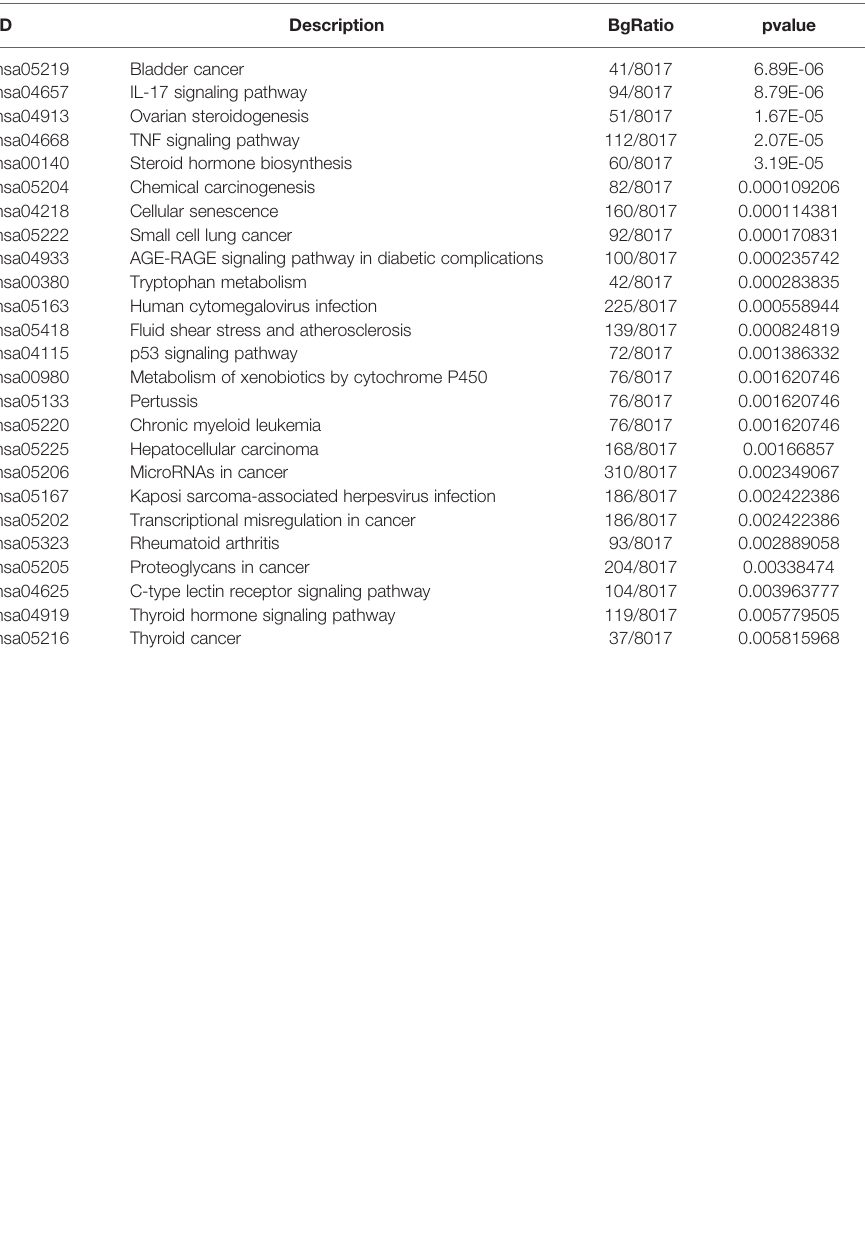
TABLE 2 | Major targets in the KEGG pathway that are signi fi cantly